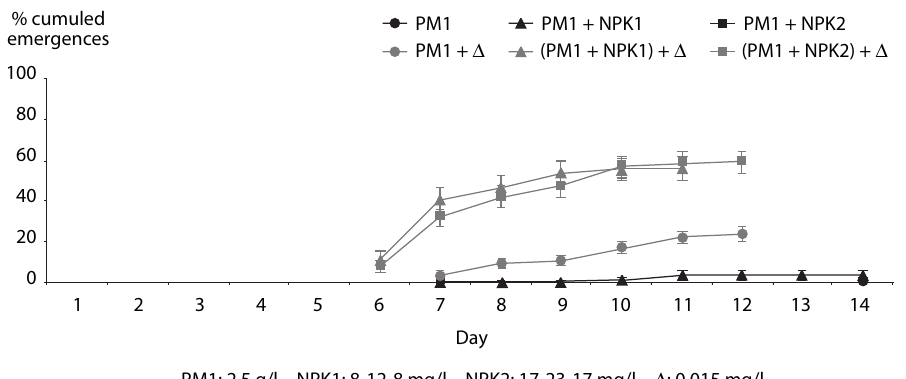
Fig. 3. – Cumulated percen- tages of male and female adults of Anopheles gambiae VKPR strain whose larvae lived in environments composed of plant matter (PM2) alone or in combination with a NPK fertilizer, treated or untreated with deltamethrin ( Δ